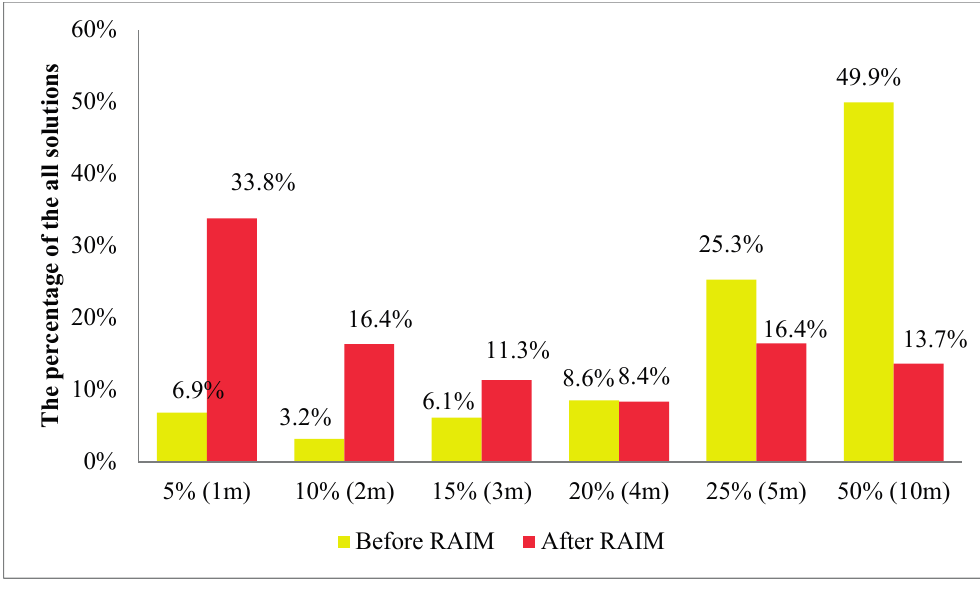
Figure 16. Histogram of the lateral positioning error of the proposed 3D map method before and after using the RAIM satellite selection method in the deep urban